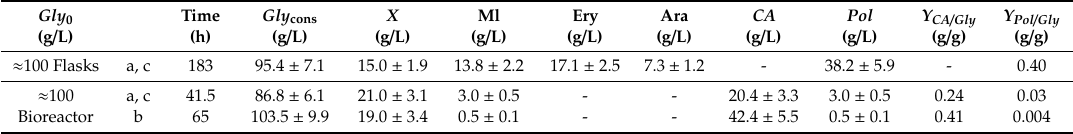
Table 3. Quantitative data of cultures of Yarrowia lipolytica LMBF Y-46 on glycerol-based media in which initial glycerol concentration ( Gly 0 ) ≈ 100 g / L was added (nitrogen was added as ammonium sulfate at 2.0 g / L and yeast extract at 3.0 g / L) in shake-flask and batch bioreactor experiments. Culture conditions: for the flask experiment as in Table 1. For the bioreactor experiment: agitation 800 ± 5 rpm, pH = 6.0 ± 0.1, aeration fluctuating from 0.1 up to 2.0 vvm in order to have a DOT ≥ 10% v / v , incubation temperature T = 28 ± 1 ◦ C, active volume = 2.0 L. Culture details when the maximum